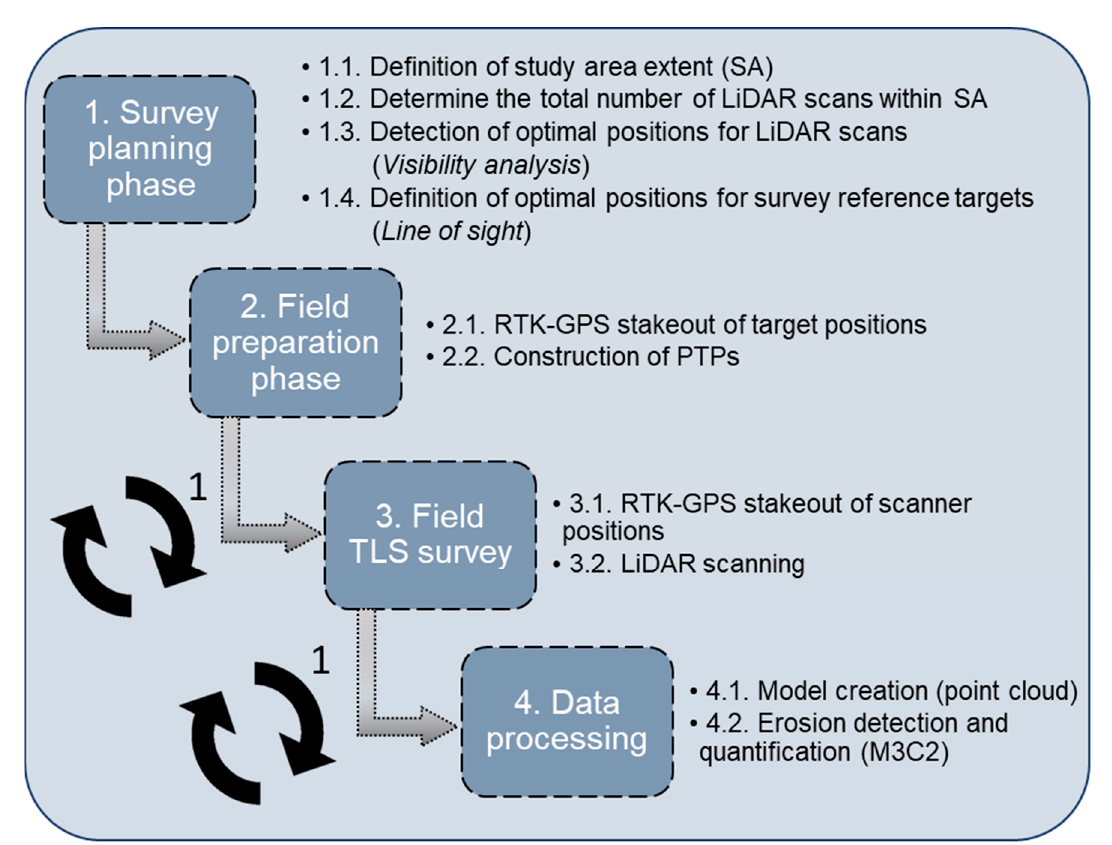
Figure 2. Four main steps of a new systematic framework for optimization of multi-temporal terrestrial LiDAR surveys.